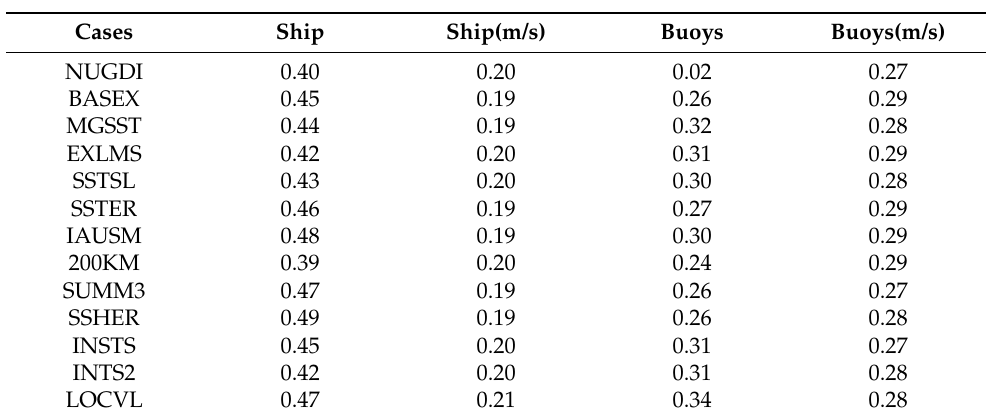
Table 5. Correlation (2nd and 4th columns) and RMSD (in m/s, 3rd and 5th columns) between modeled and observed velocity data at 0–100 m depths for the period from July 1 to August 31, 2020. The observed locations were the same as those of temperature data (Table 4). Correlation and RMSD for the velocity data were calculated for all scalar values composed of east–west ( u ) and north–south ( v ) components, e.g., RMSD = of the u / v data, “a” and “o” denote modeled and observed velocities, respectively.